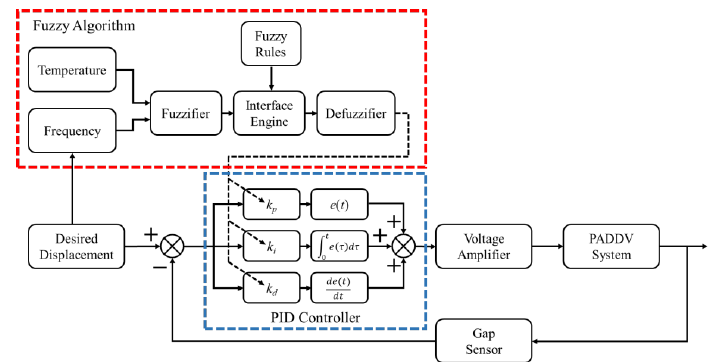
Table 3. Fuzzy rules for P gain ( k p ).